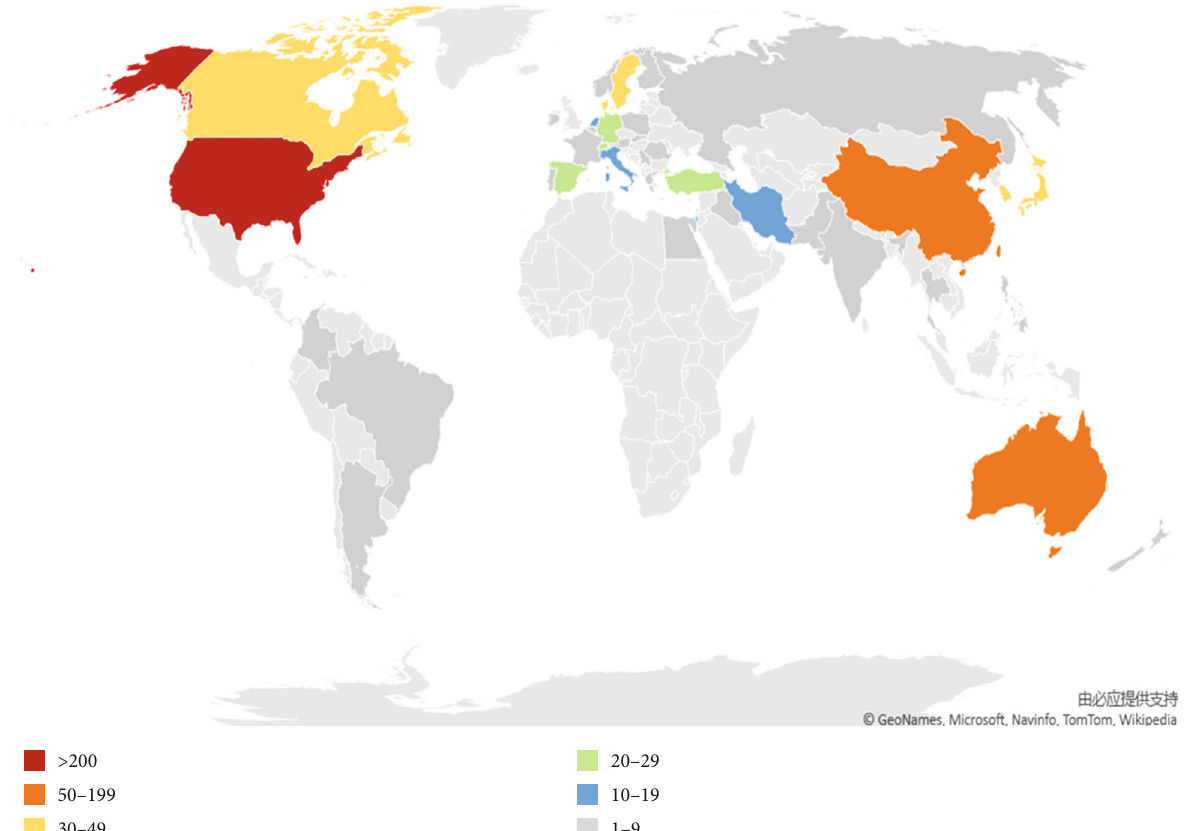
Figure 8: World map of the total country output based on pain after spinal cord